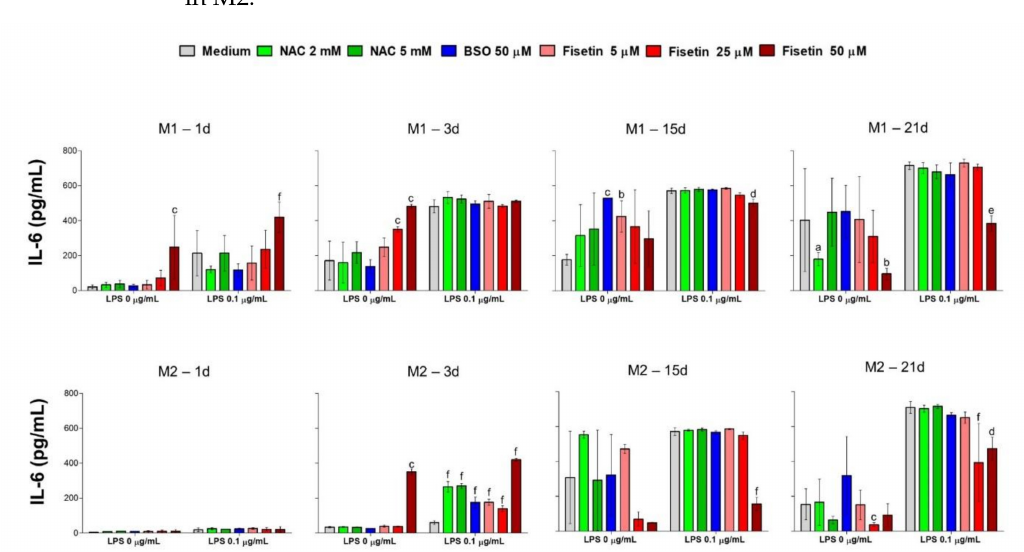
Figure 6. Interleukin-6 released from human pulp cells in the various experimental